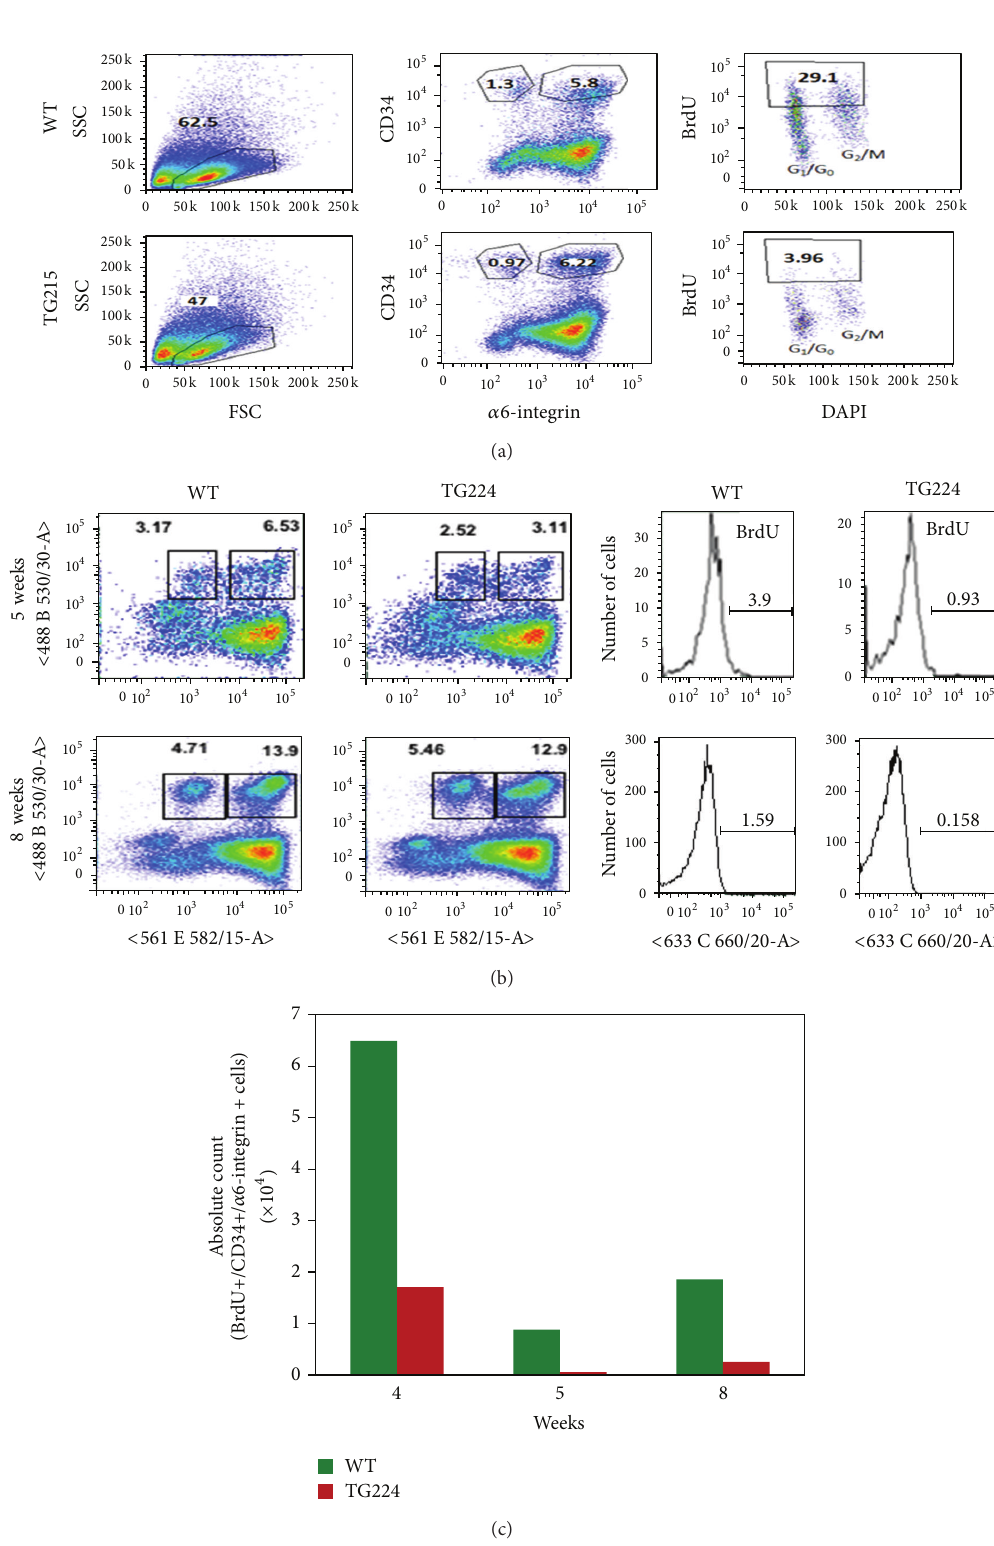
Figure 5: PKC 𝜀 overexpressing transgenic mice have increased turnover of HSCs as determined by BrdU retaining double positive HSCs (CD34+/ 𝛼 6-integrin+). To identify LRCs, newborn mice (3 days old) were injected subcutaneously with BrdU (50mg/Kg body weight) twice daily for 3 days. Mice were then sacrificed at 8 weeks after the last BrdU injection. There were four mice per group. (a) Representative gating of cell populations for side scatter (SSC) versus forward scatter (FSC). (b) Representative gating of cell populations at 5 and 8 weeks in the indicated mice. (c) Frequency of total BrdU-labeled double positive (CD34+/ 𝛼 6-integrin+) keratinocytes in TG 224 and their WT littermates at 4, 5, and 8